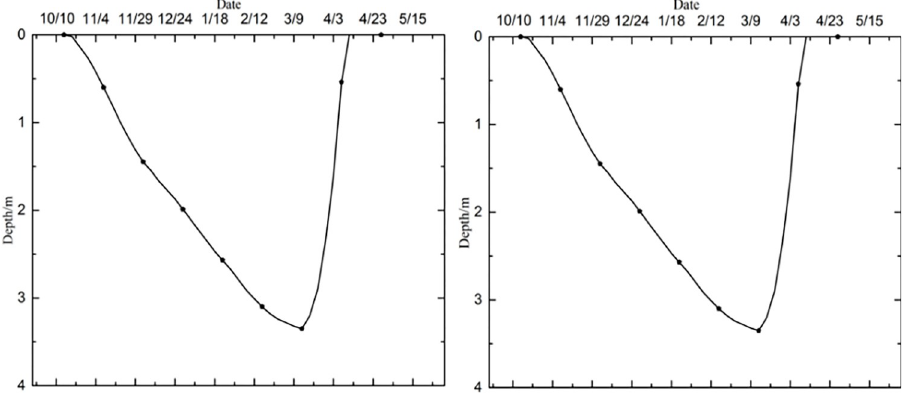
Fig 4. Depth of the frozen layer after 10 years of operation at (a) the center and (b) edge of the